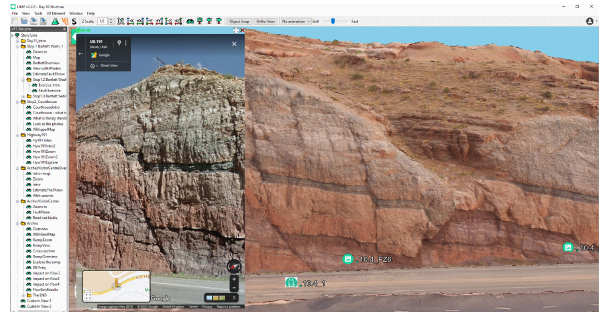
Figure 5. Arches Road Cut, Utah, USA (https://v3geo.com/model/ 98, last access: 7 March 2022, CC BY-NC), one of the stops on the University of Aberdeen MSc virtual field trip to Utah. Multiple days of VFT content are prepared in LIME using multiple V3Geo models and additional material, including photos, 360 ◦ panorama images, logs and other field data types, and shared with students during the course. Inset © Google